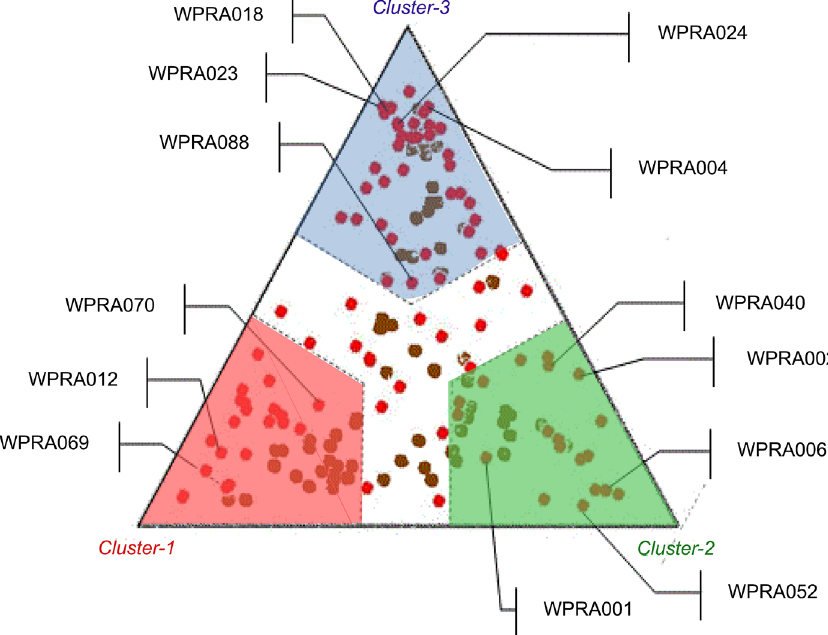
Fig 4. Association between the degree of Amerindian ancestry and low dose requirements. ID codes depicted for those requiring <